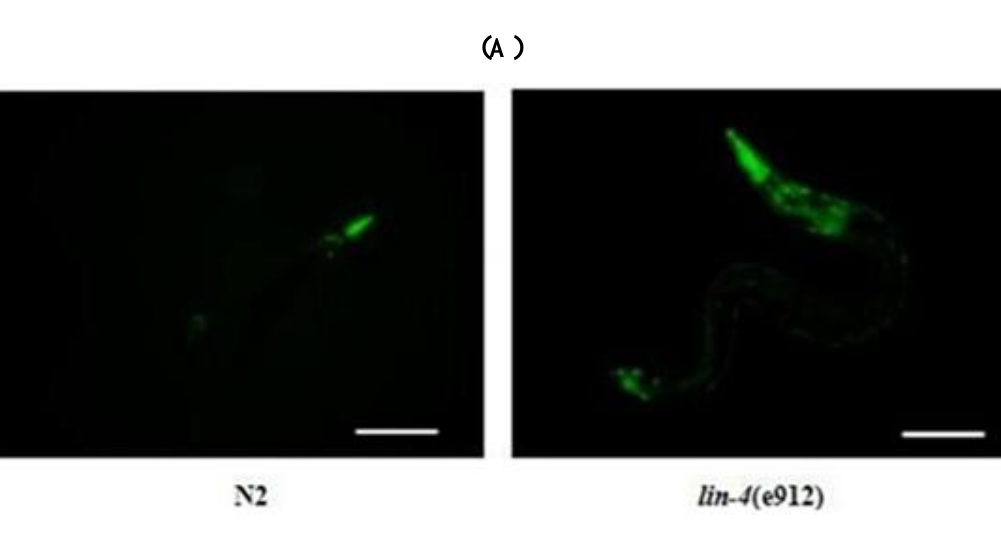
Figure 3. The effect of lin-4 on ROS level. ( A ) Intracellular ROS in C. elegans were measured using 2,7-dichlorofluorescein diacetate (DCF-DA; Molecular Probes). Sixty animals from each group were analyzed ( n = 60). Scale bar: 100 μm; ( B ) results are expressed as mean ± SD of relative fluorescence units (RFU). * p <